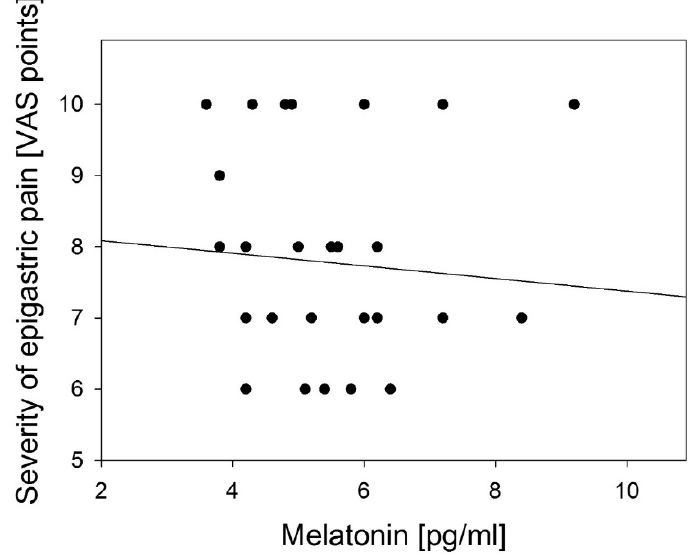
Figure 9. Correlation between fasting serum melatonin level and the severity of epigastric pain assessed by Visual Analog Scale (VAS) in patients with continuous epigastric pain syndrome ( n = 30). Regression line was calculated by means of the last square method, the R value was equal to − 0.698, p <